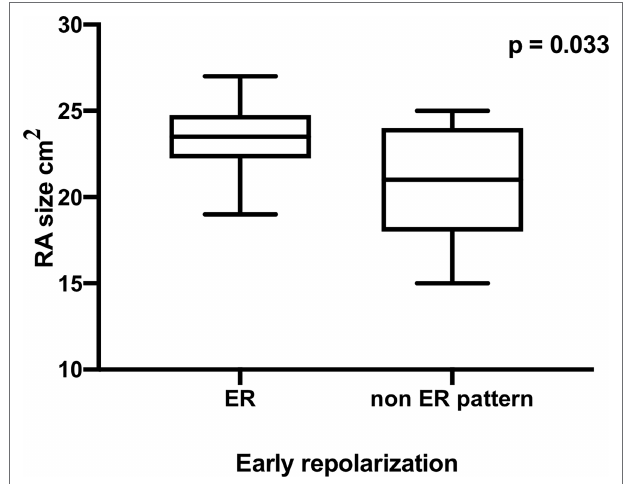
FIGURE 4 | Significantly enlarged RA endsystolic diameter in professional basketball players with early repolarization (ER) compared to non-ER pattern.